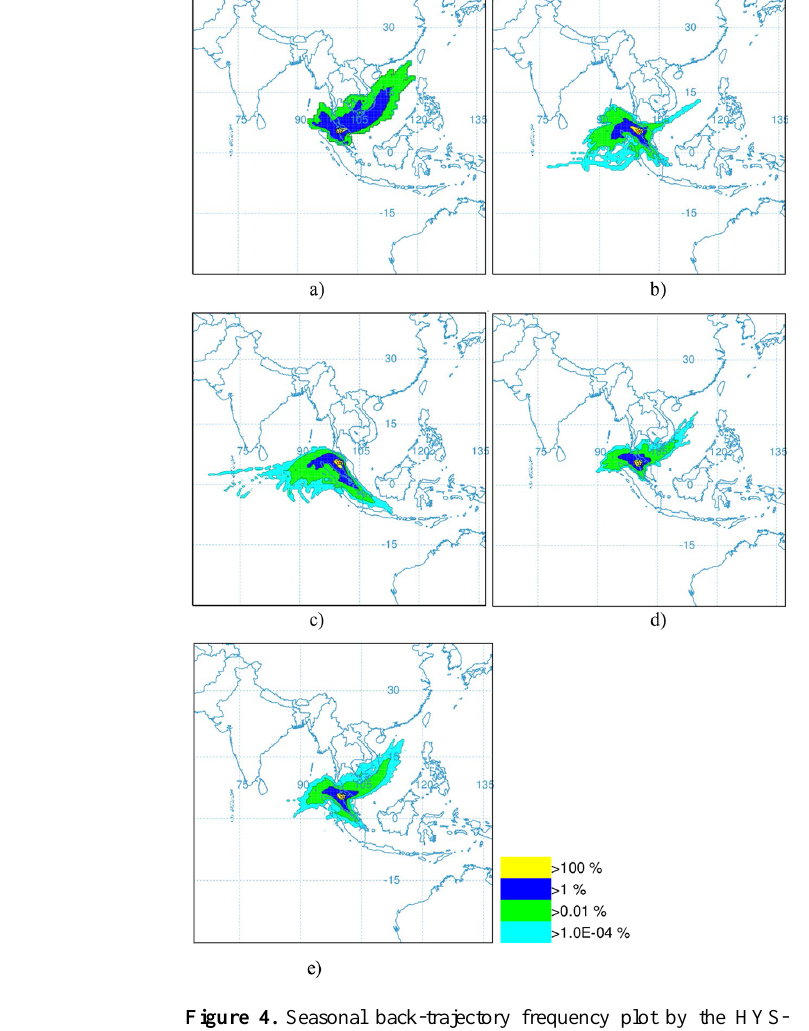
Figure 4. Seasonal back-trajectory frequency plot by the HYS- PLIT_4 model (Draxler and Hess, 1998) for (a) northeast monsoon, (b) pre-monsoon, (c) southwest monsoon, (d) post-monsoon, and (e) overall study period at Penang, which was marked as a five- edged star (5.50 ◦ N and 100.50 ◦ E, from altitude